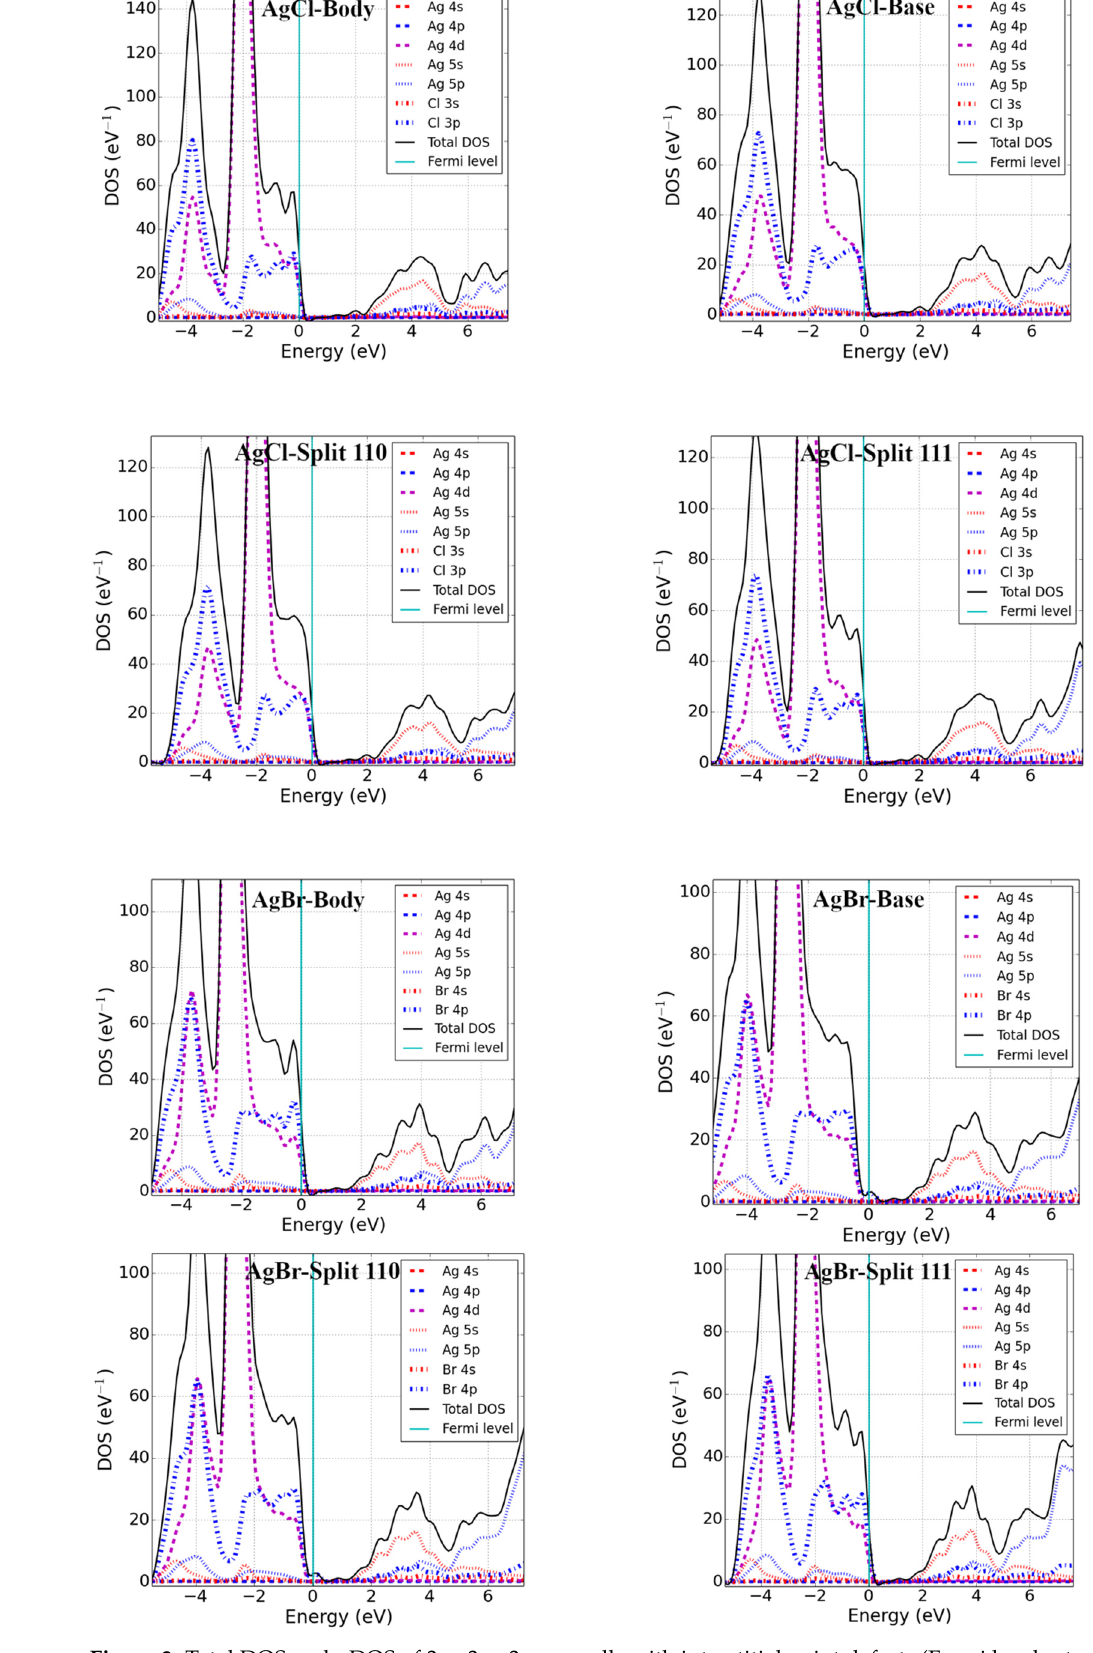
Figure 3. Total DOS and pDOS of 3 × 3 × 3 supercells with interstitial point defects (Fermi level set to zero).